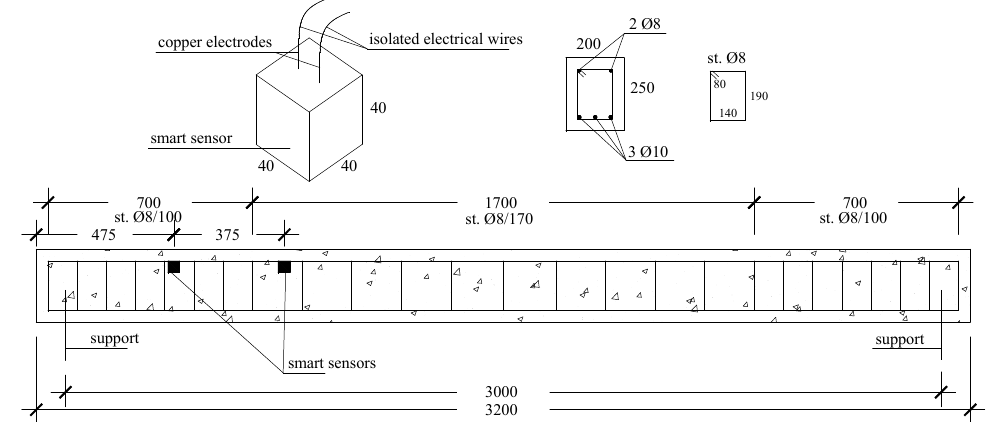
Figure 5. Sketch of the dimensions and reinforcements of the full-scale beam with embedded smart sensors, cross-section, and representation of a single smart